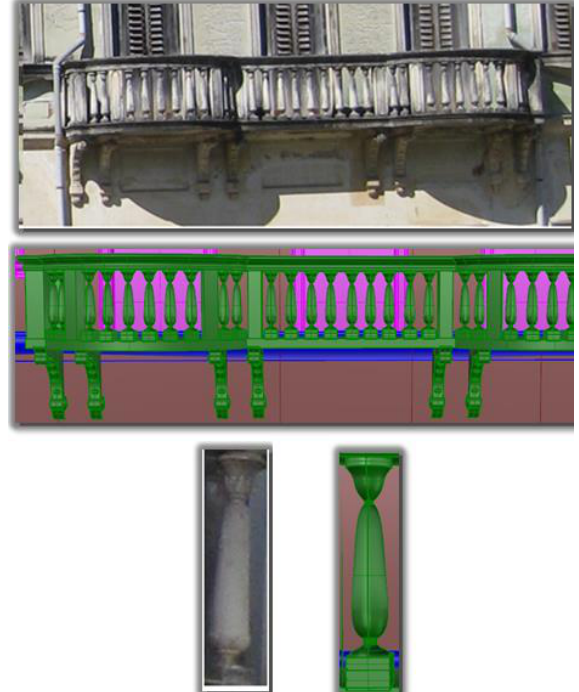
Figure 17: Modeling of balaustrade elements with simplified solid geometries